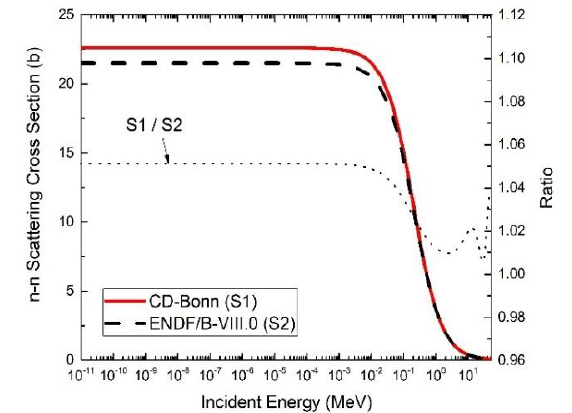
Fig. 1. The evaluated results for neutron-neutron scattering data based on the CD-Bonn interaction.